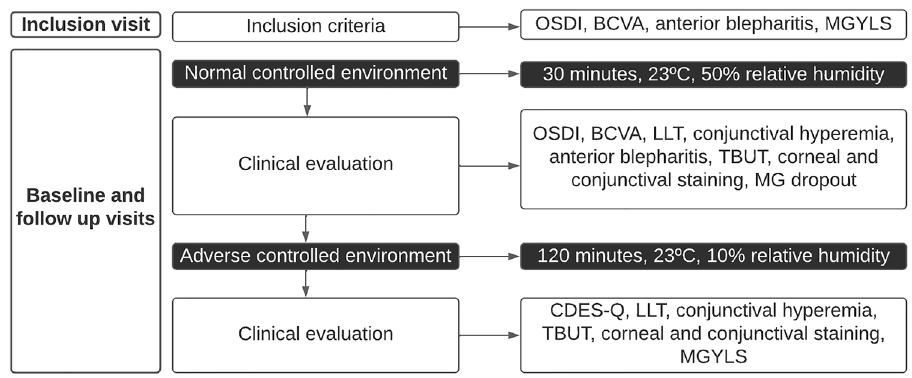
Figure 1. Chronological scheme of the tests performed at each visit. OSDI = ocular surface disease index, BCVA = best corrected visual acuity, MGYLS = meibomian gland yielding liquid secretion, LLT = lipid layer thickness, TBUT = tear break-up time, MG = Meibomian glands, CDES-Q = change in dry eye symptoms